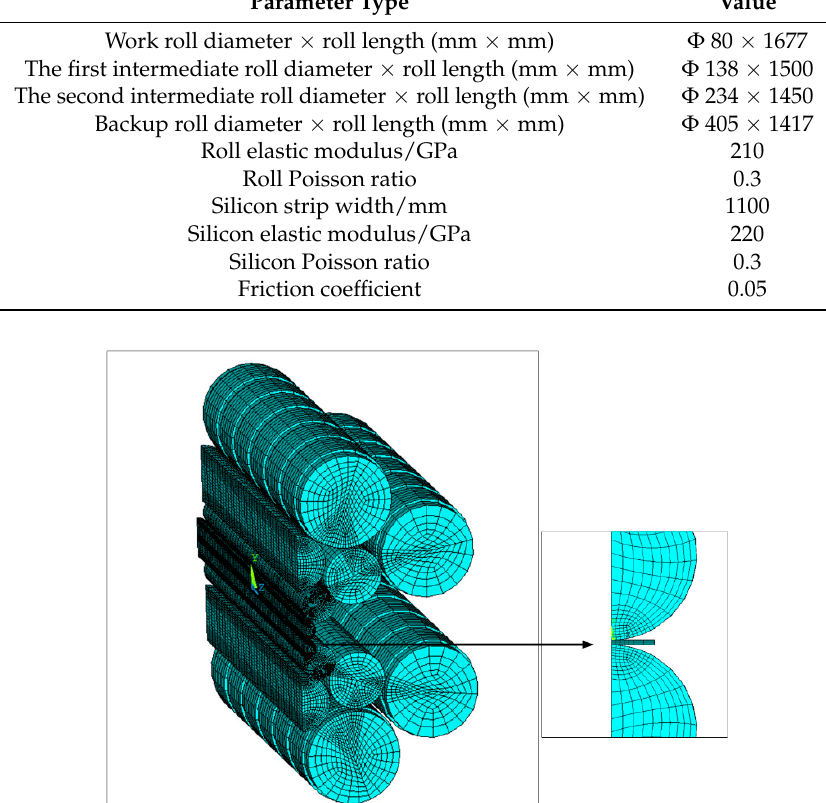
Figure 1. Roll system and strip-integrated statics model.